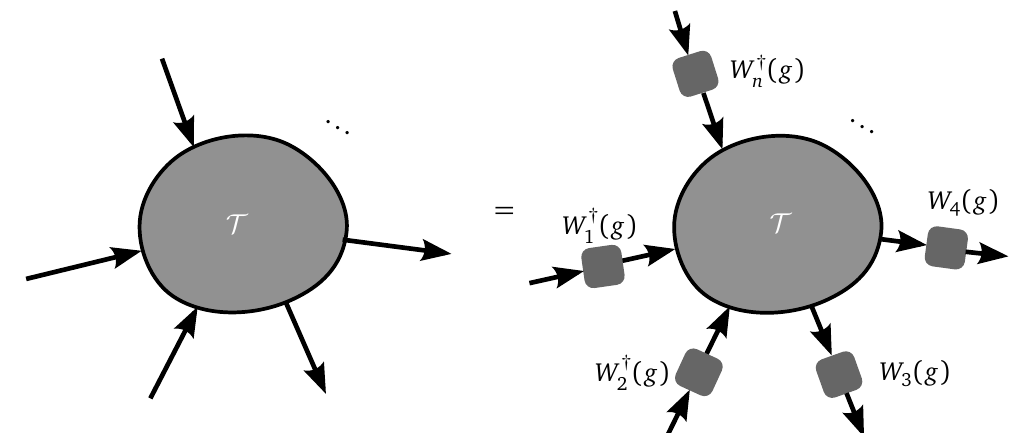
Figure 12: Graphical representation of an Abelian symmetric tensor (left) with n directed links. Incoming links are drawn as arrows directed towards the tensor.